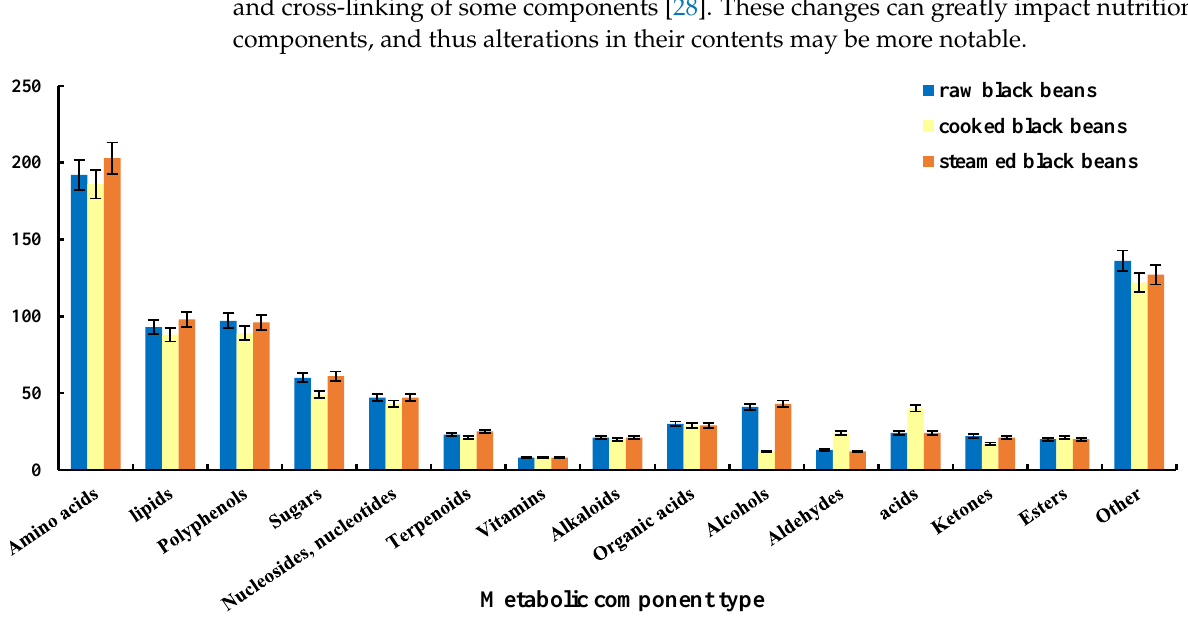
Figure 1. Comparison of the number of metabolic components in raw, steamed, and cooked black beans.